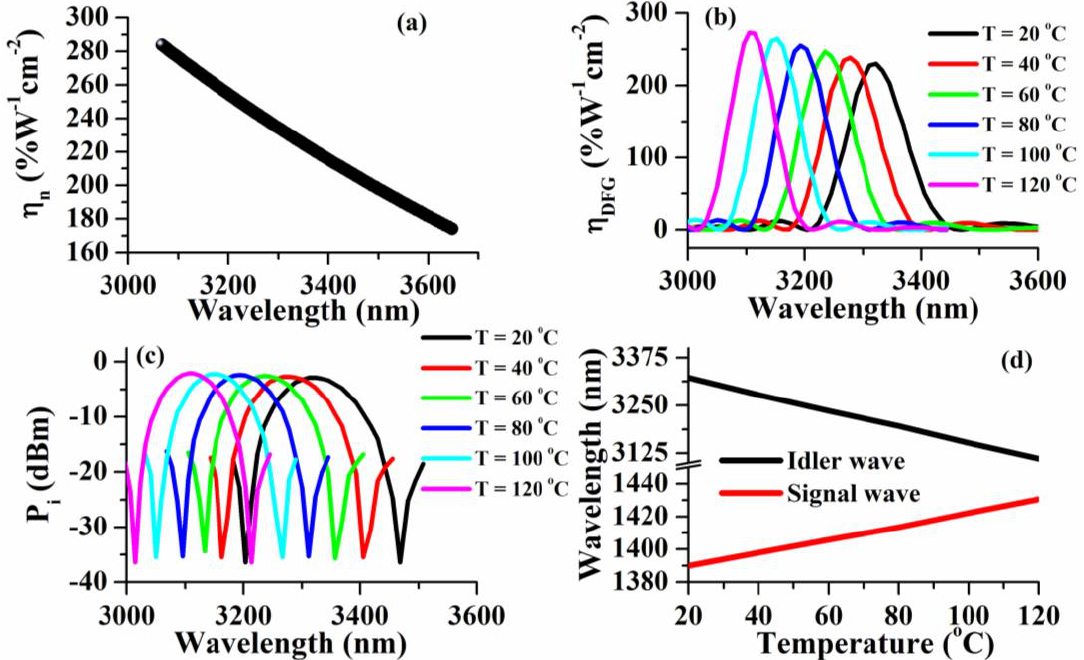
Figure 12. ( a ) Normalized efficiency η n as a function of wavelength; ( b ) DFG efficiency η DFG as a function of MIR wavelength at different temperatures ranging from 20 to 120 °C; ( c ) idler wave output power P i as a function of MIR wavelength at different temperatures ranging from 20 to 120 °C when P p = 20 dBm and P s = 11.5 dBm; ( d ) temperature tuning curve of DFG device.